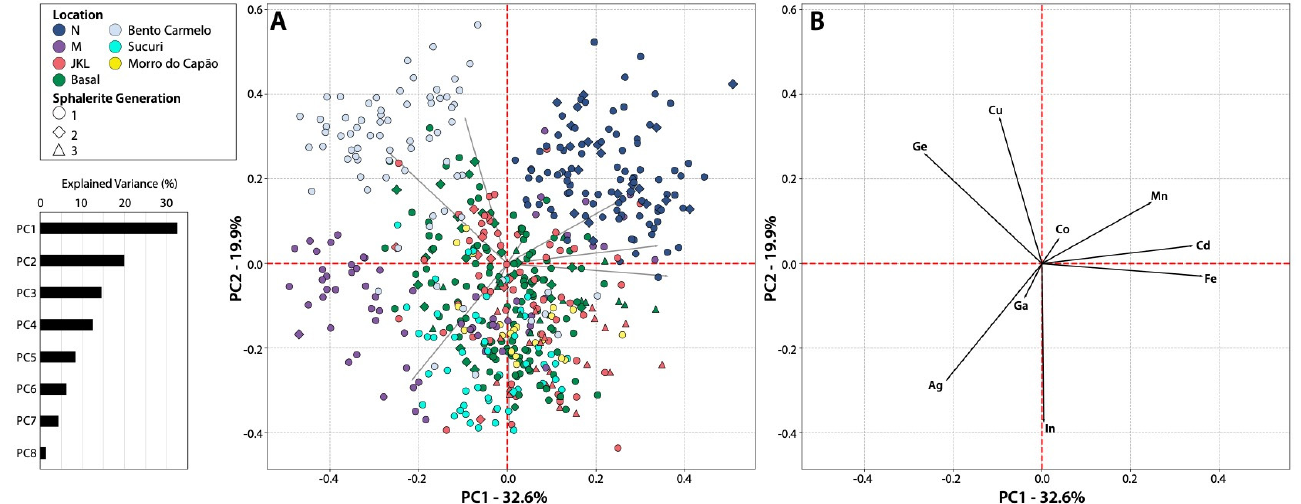
Figure 13. Principal components (PCs) for the sphalerite mineral chemistry using a reduced dataset from the Morro Agudo district (according to Frenzel et al. [27] for geothermometric applications); ( A ) biplot of the PC1 (32.6%) vs. PC2 (19.9%) plane displaying the spot analyses; ( B ) elements located in PC1 and PC2.